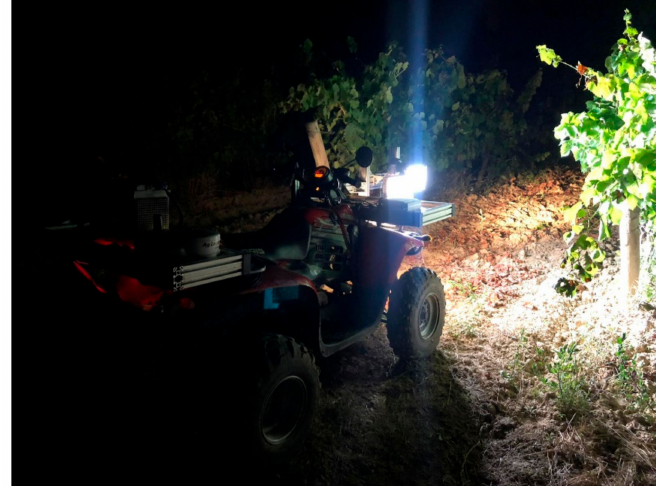
Figure 1. Mobile sensing platform for on-the-go image acquisition: a modified all-terrain vehicle (ATV) incorporating a red, green, blue (RGB) camera, Global Positioning System (GPS), and an artificial illumination system mounted on an adaptable